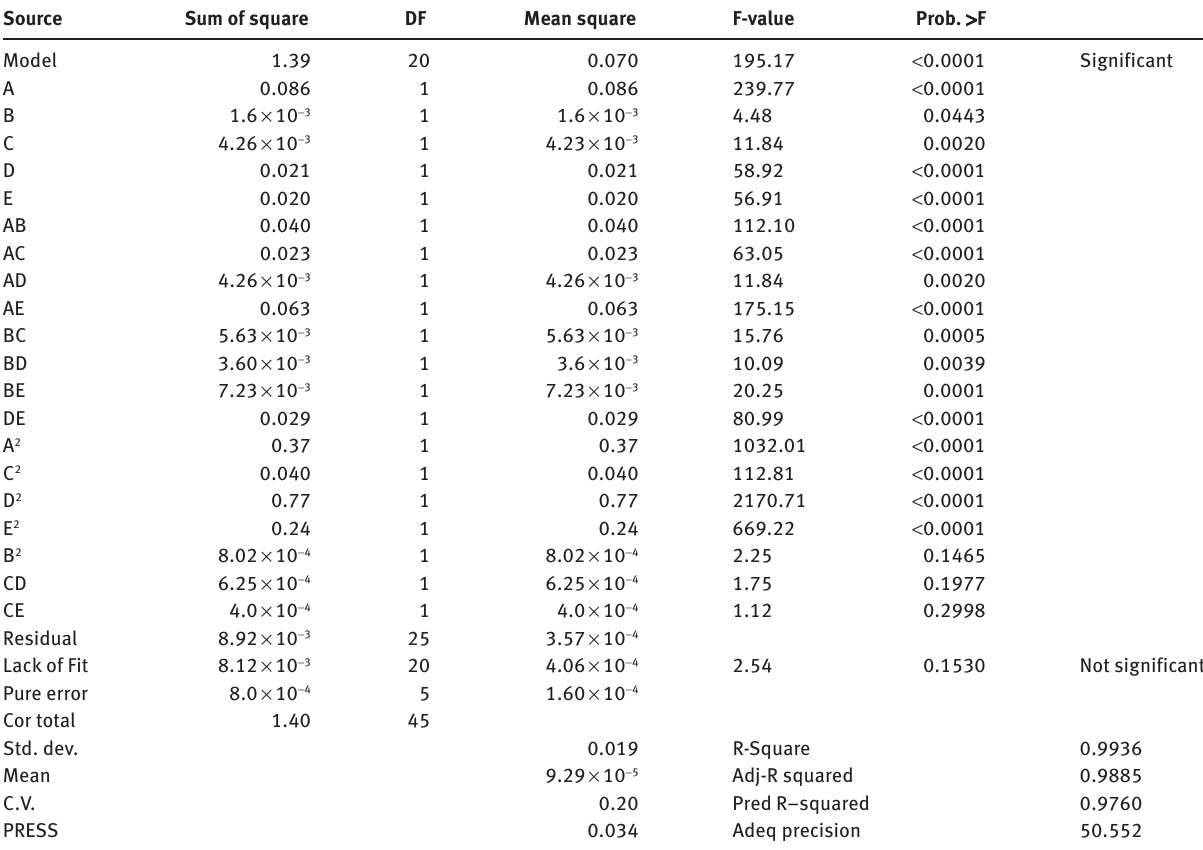
Table 4: ANOVA table for wear rate. Source Sum of square DF Mean square